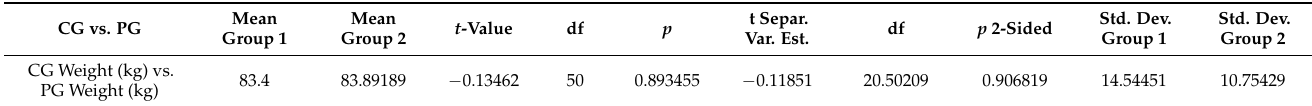
Table 3. Characteristics of the t -test